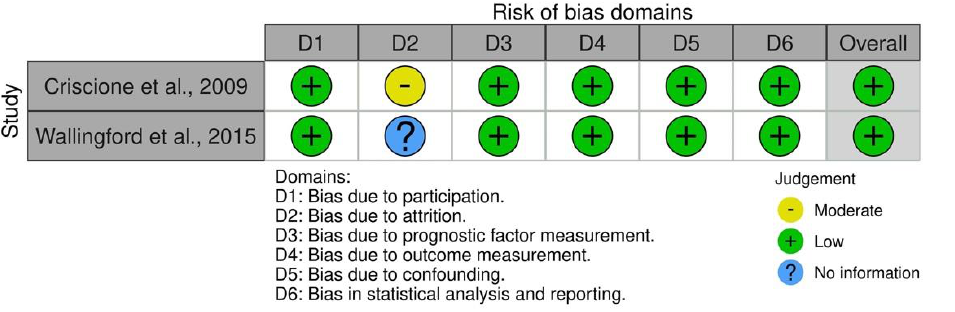
Figure 2. Evaluation of risk of bias using the QUIPS tool. Both studies were considered to have an overall low risk of bias. QUIPS, Quality in Prognosis Studies.